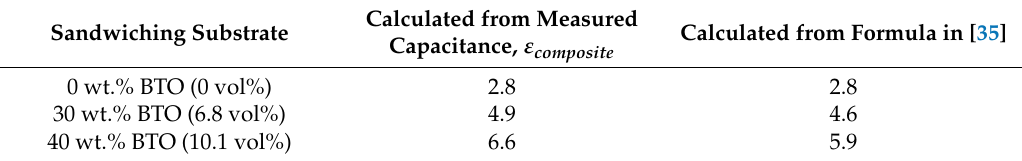
Table 3. Comparison of the relative permittivity of the composite substrate.